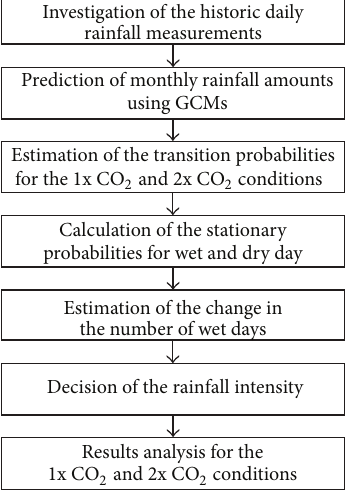
Figure 4: General framework of this